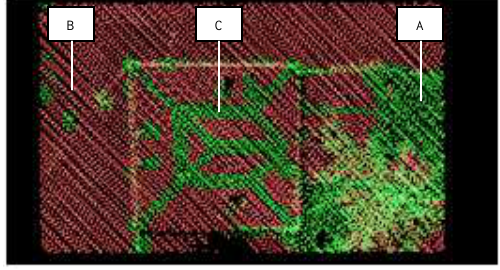
Figure 3. Results of PCA process of LIDAR points (green points are non-planar while red ones is planar) Seed points are then selected from the determined planar